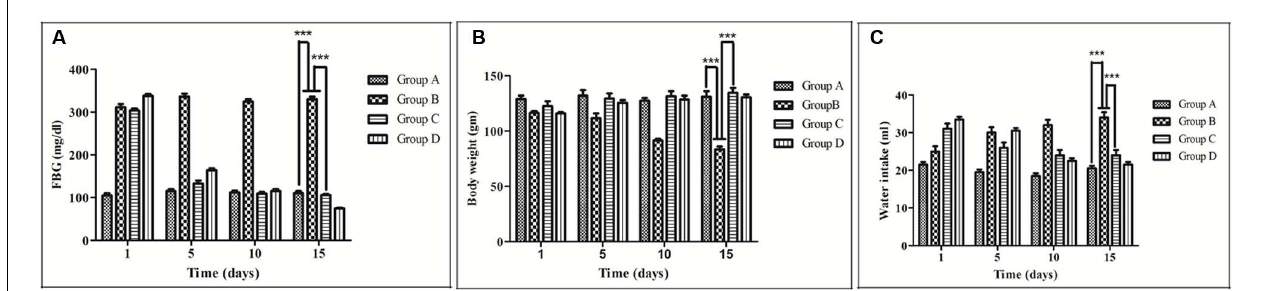
FIGURE 2 | Effect of Musa balbisiana root extract on different parameters. (A) Fasting blood glucose (FBG) (B) Body weight changes (C) Water intake. All the results were expressed in mean ± SEM (n = 6); ∗∗∗ p < 0.001 in comparison between different groups.